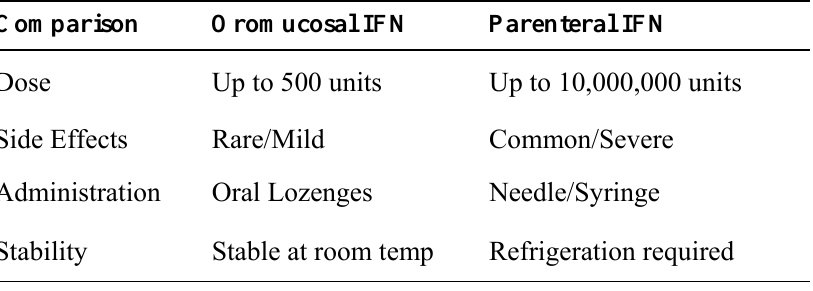
Table 1. Comparison of Oromucosal and Parenteral